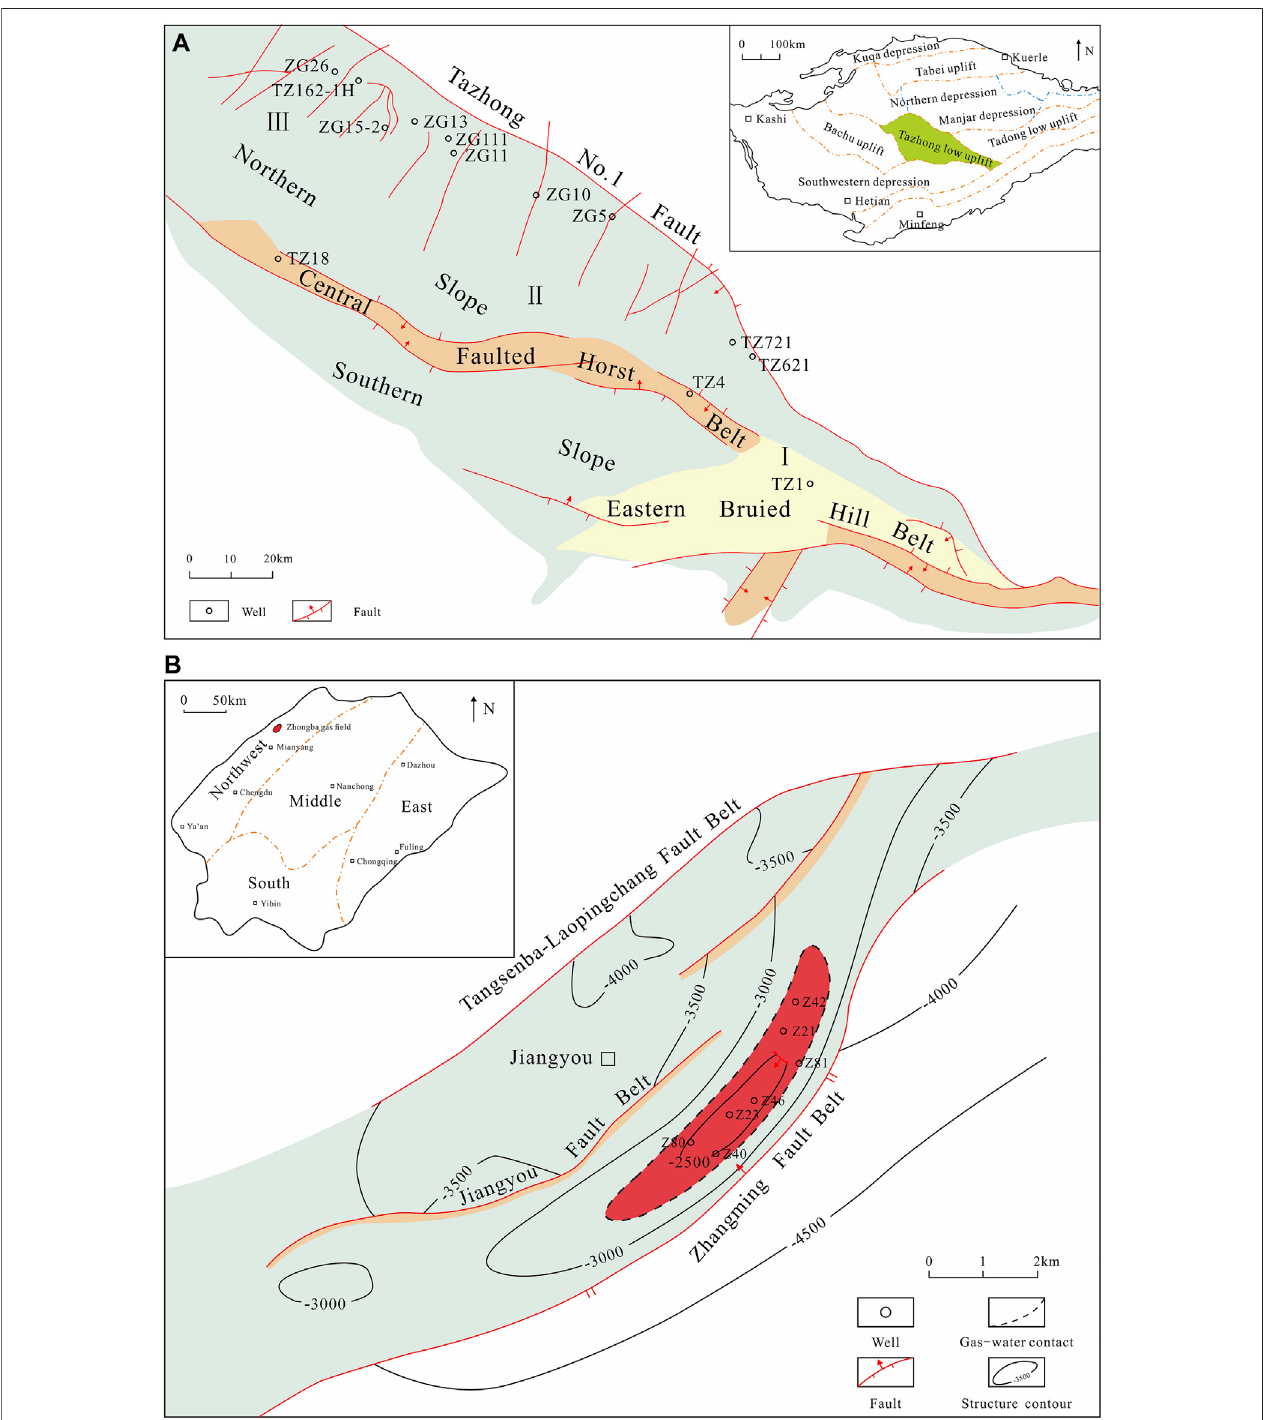
FIGURE 1 | Sketch maps showing the location of the TZ-I gas fi eld in Tarim basin (A) (modi fi ed after Wu et al., 2014 and Guan et al., 2020) and ZB gas fi eld in Sichuan basin (B) (modi fi ed from Zhu et al., 2011).